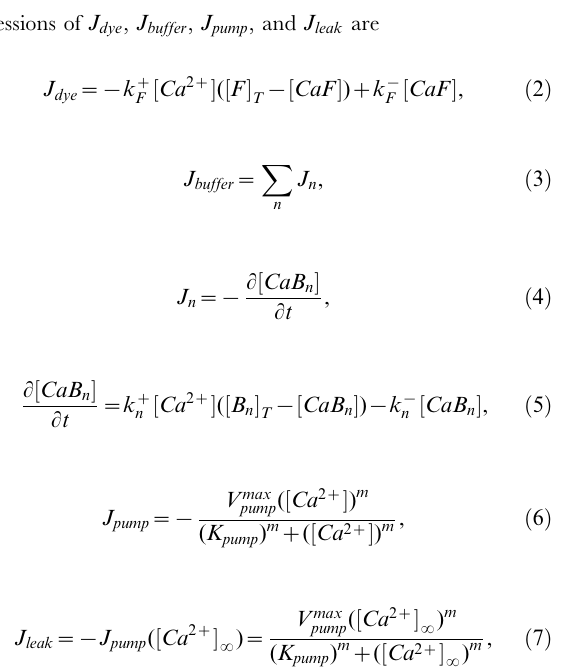
Figure 1. The 2D model of a cardiac myocyte. The black dots represent CRUs which distribute regularly spaced l x along x -axis and l y along y -axis.